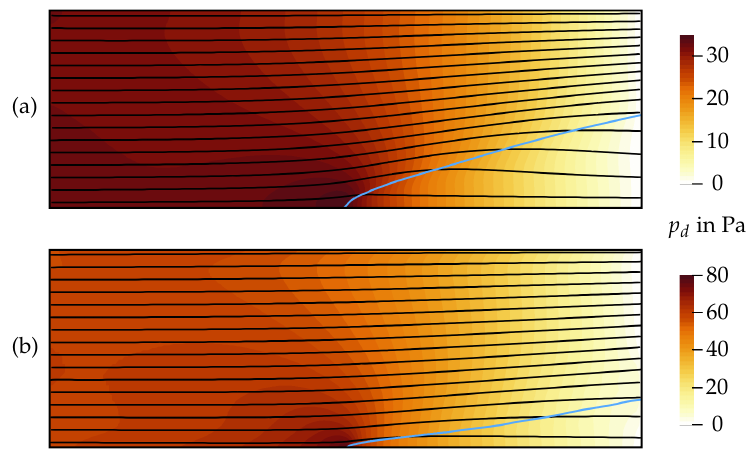
Figure 11. Average streamlines, average flame shape and average pressure field of the stable cases at U b = 10ms − 1 at ( a ) p = 0.5bar and at ( b ) p = 3bar. The average flame shape is represented by the blue c = 0.5